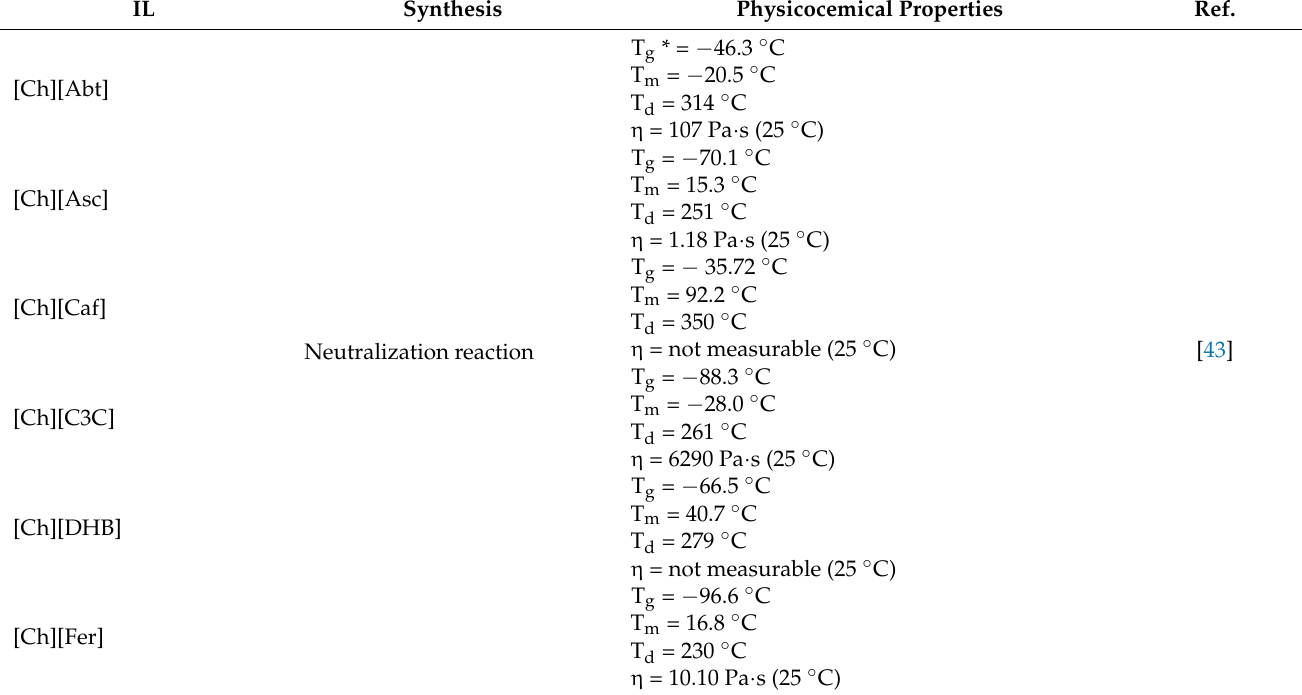
Table 1. Overview of recently investigated